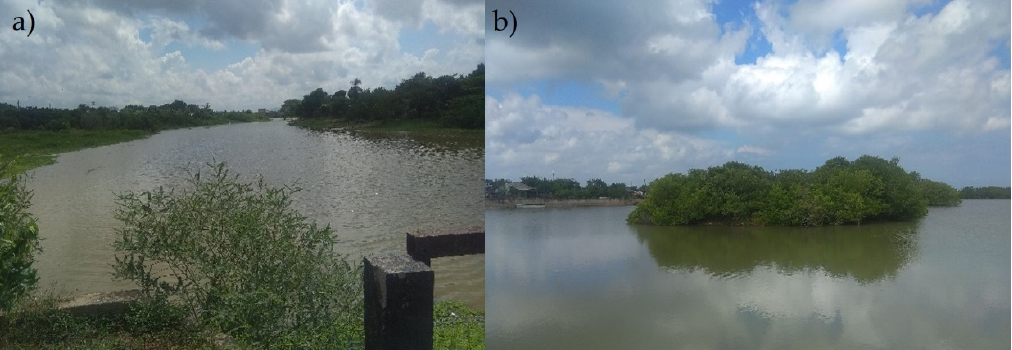
Figure 7. ( a ) Eastern side of Totumo Swamp characterized by fresh water conditions; ( b ) mangrove remnants ( Rhizophora mangle ) in the western side of Totumo Swamp characterized by brackish water conditions.